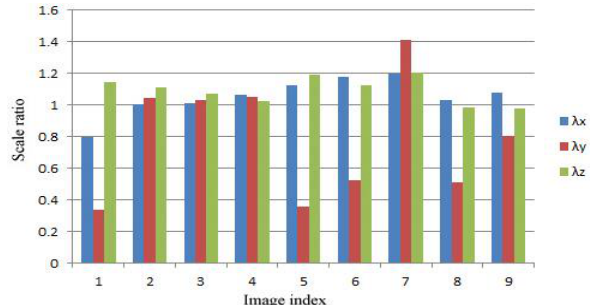
Figure 6. Scale ratios between the 3D reconstructed ground truth layout and the created